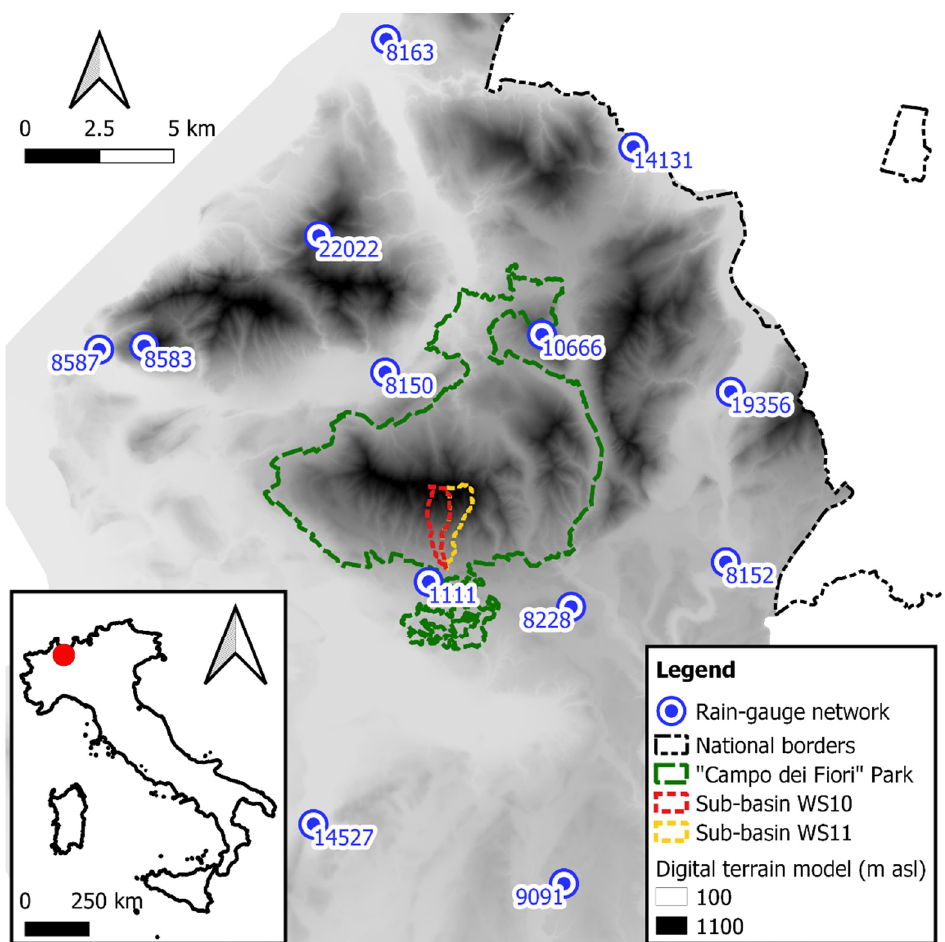
Figure 1. Position of the Tinella watershed, its two sub-basins (WS10 and WS11) and the rain gauge network present in the study area.